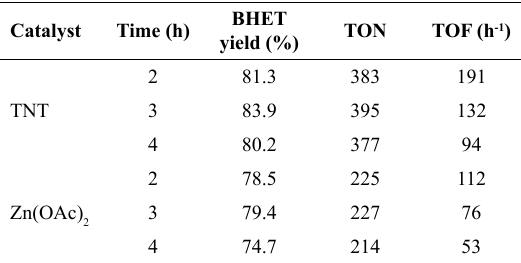
Table 2. Yield, TON and TOF results obtained for BHET from virgin PET for different reaction times.